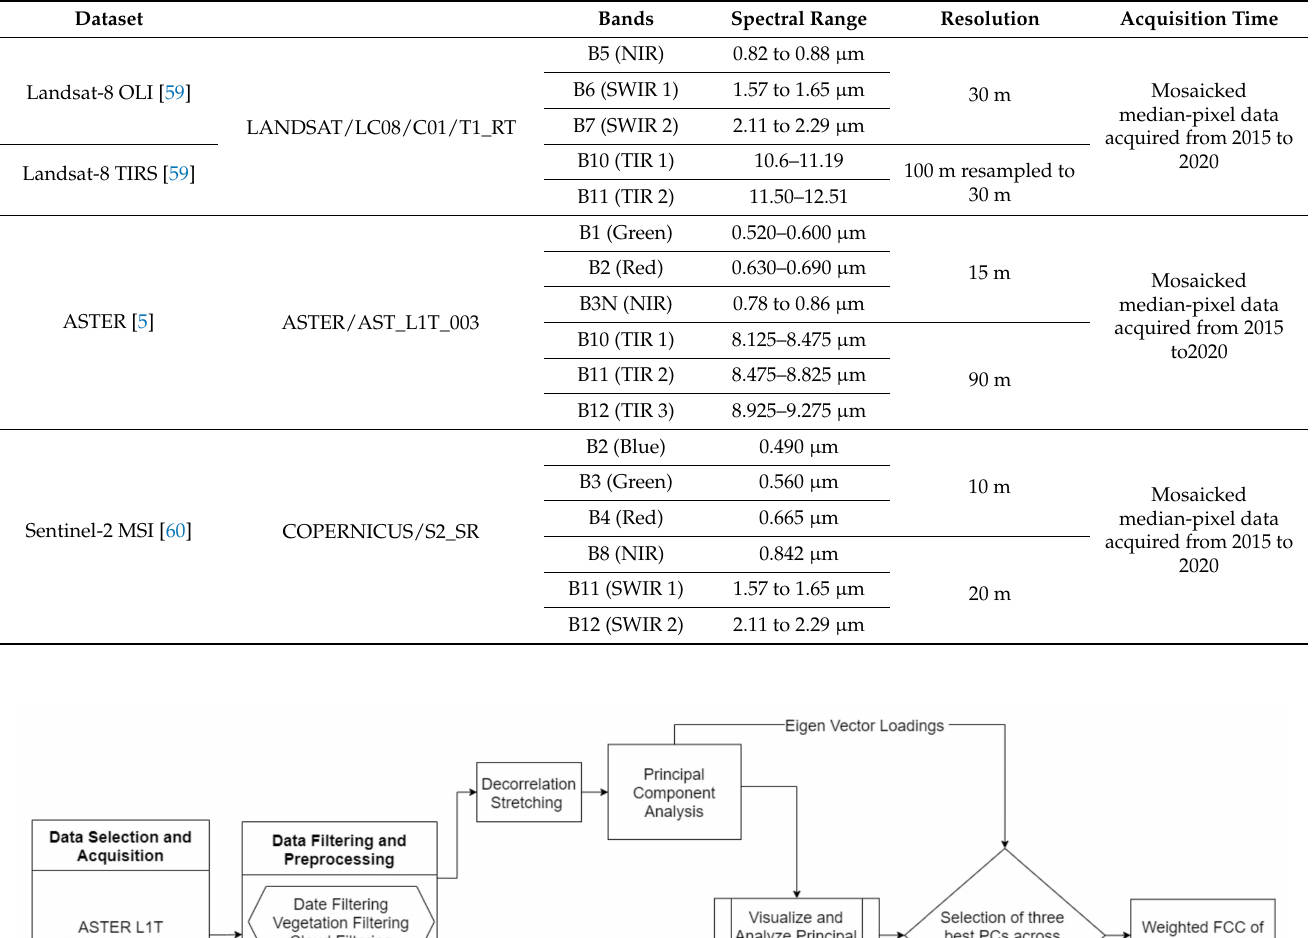
Table 1. Relevant near infrared (NIR) and shortwave infrared (SWIR) bands of each dataset.